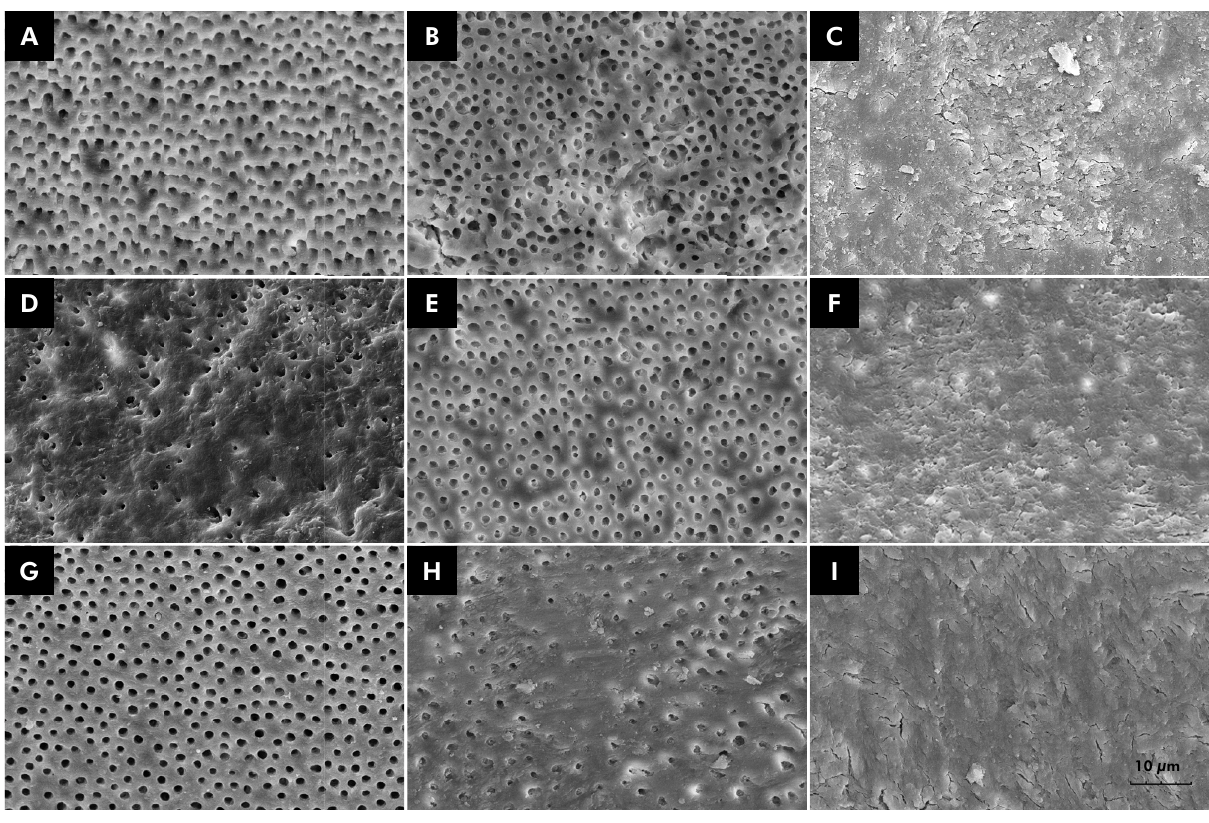
Figure 1. Smear layer on root dentin. Representative images of the PAA group in the cervical (a), middle (d) and apical (g) thirds; of the NaOCl-EDTA-NaOCl group in the cervical (b), middle (e) and apical (h) thirds; and of the NaOCl and saline groups in the cervical (c), middle (f) and apical (i) thirds are shown. Since there was no difference between NaOCl and saline groups, both groups are represented in the same images. Bar = 10 µm.